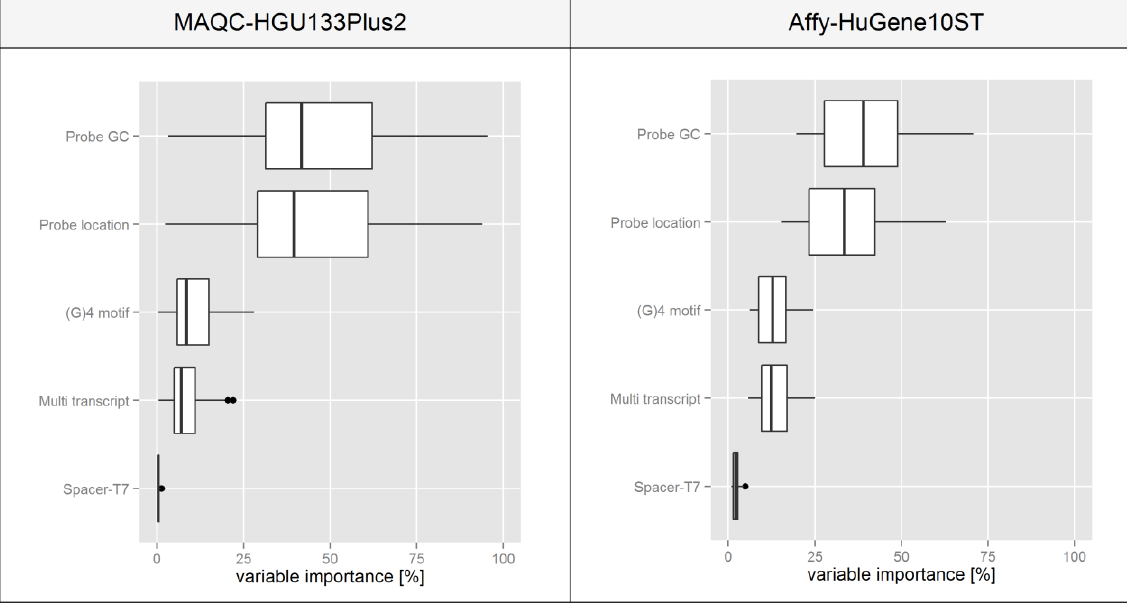
Figure 7. Boxplots representing the influence of individual features on the structure of a decision tree, which we assume reflects their influence on the intra-probeset signal